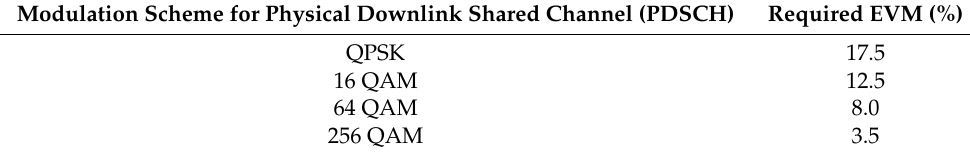
Table 1. Error vector magnitudes (EVMs) in 5G standard. Modulation Scheme for Physical Downlink Shared Channel